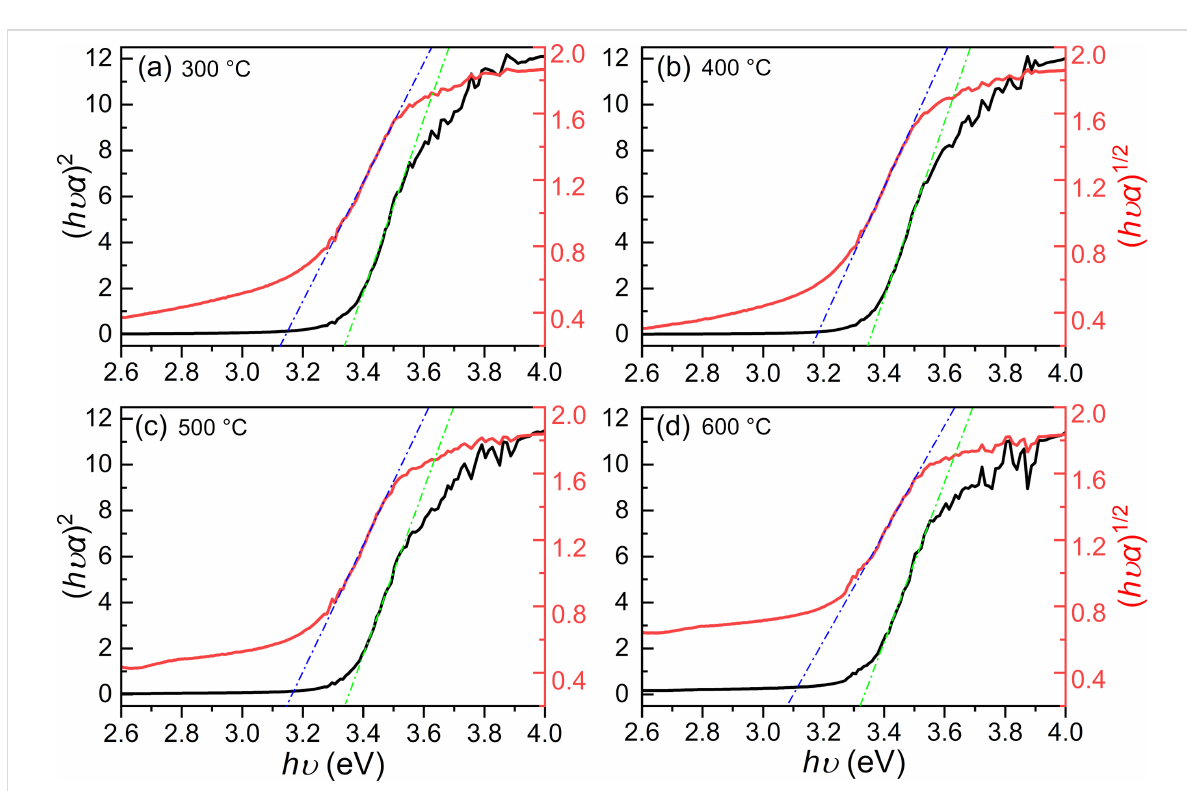
Figure 2: The bandgap values determined by the Tauc plot method from the diffuse reflectance spectra of samples calcinated at 300–600 °C. The black and red curves were calculated from the direct ( n = 1/2) and indirect transition ( n = 2),